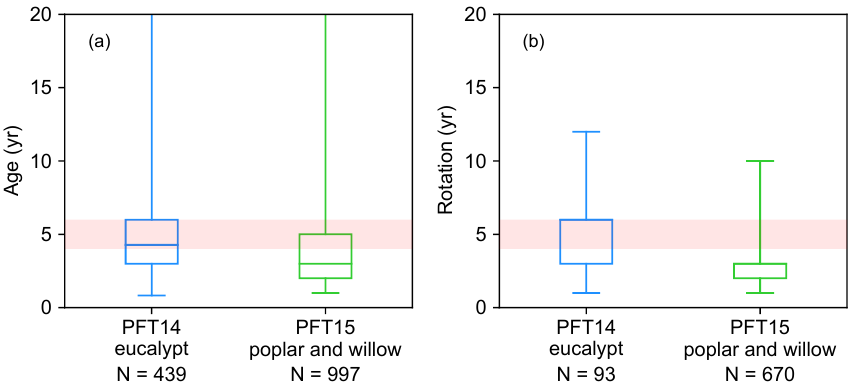
Figure 2. Harvest age (a) and rotation length (b) in the evaluation dataset. The box plot indicates the interquartile range, and the number of observations is also shown. In this study, the harvest age class is set to 4–6 years (red shading).